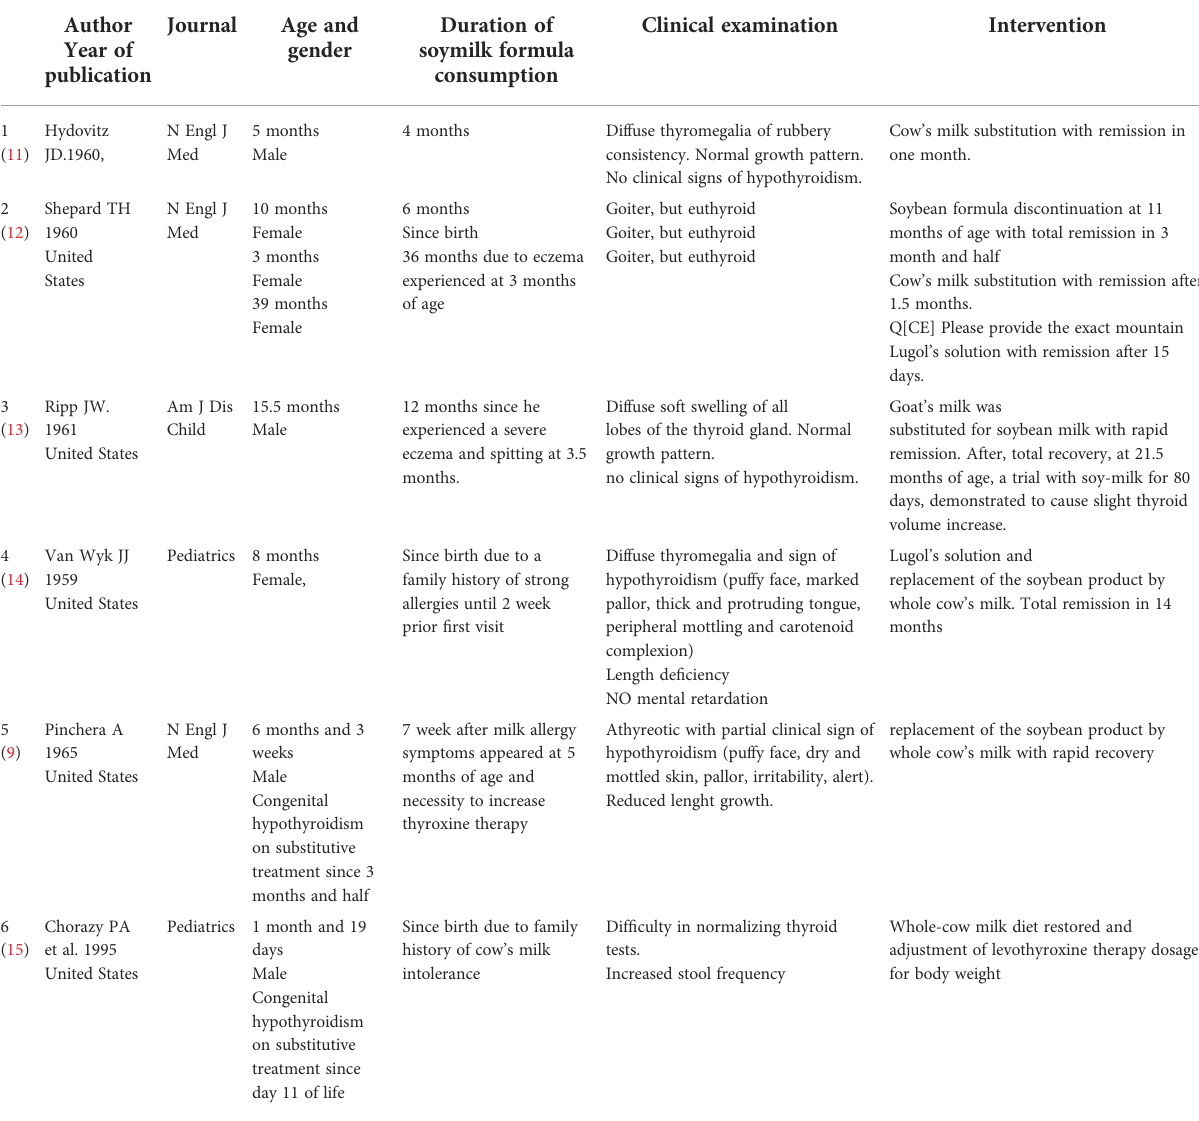
TABLE 2 Literature review of presentation and management of